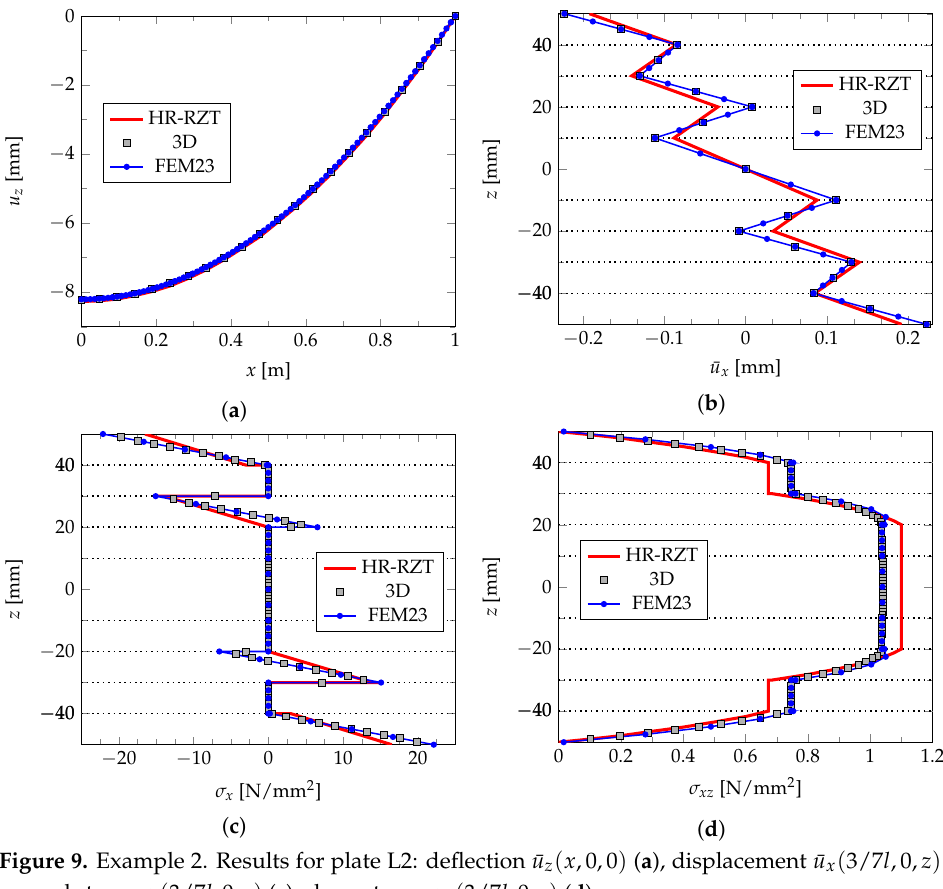
Figure 9. Example 2. Results for plate L2: deflection ¯ u z ( x ,0,0 ) ( a ), displacement ¯ u x ( 3/7 l ,0, z ) ( b ),